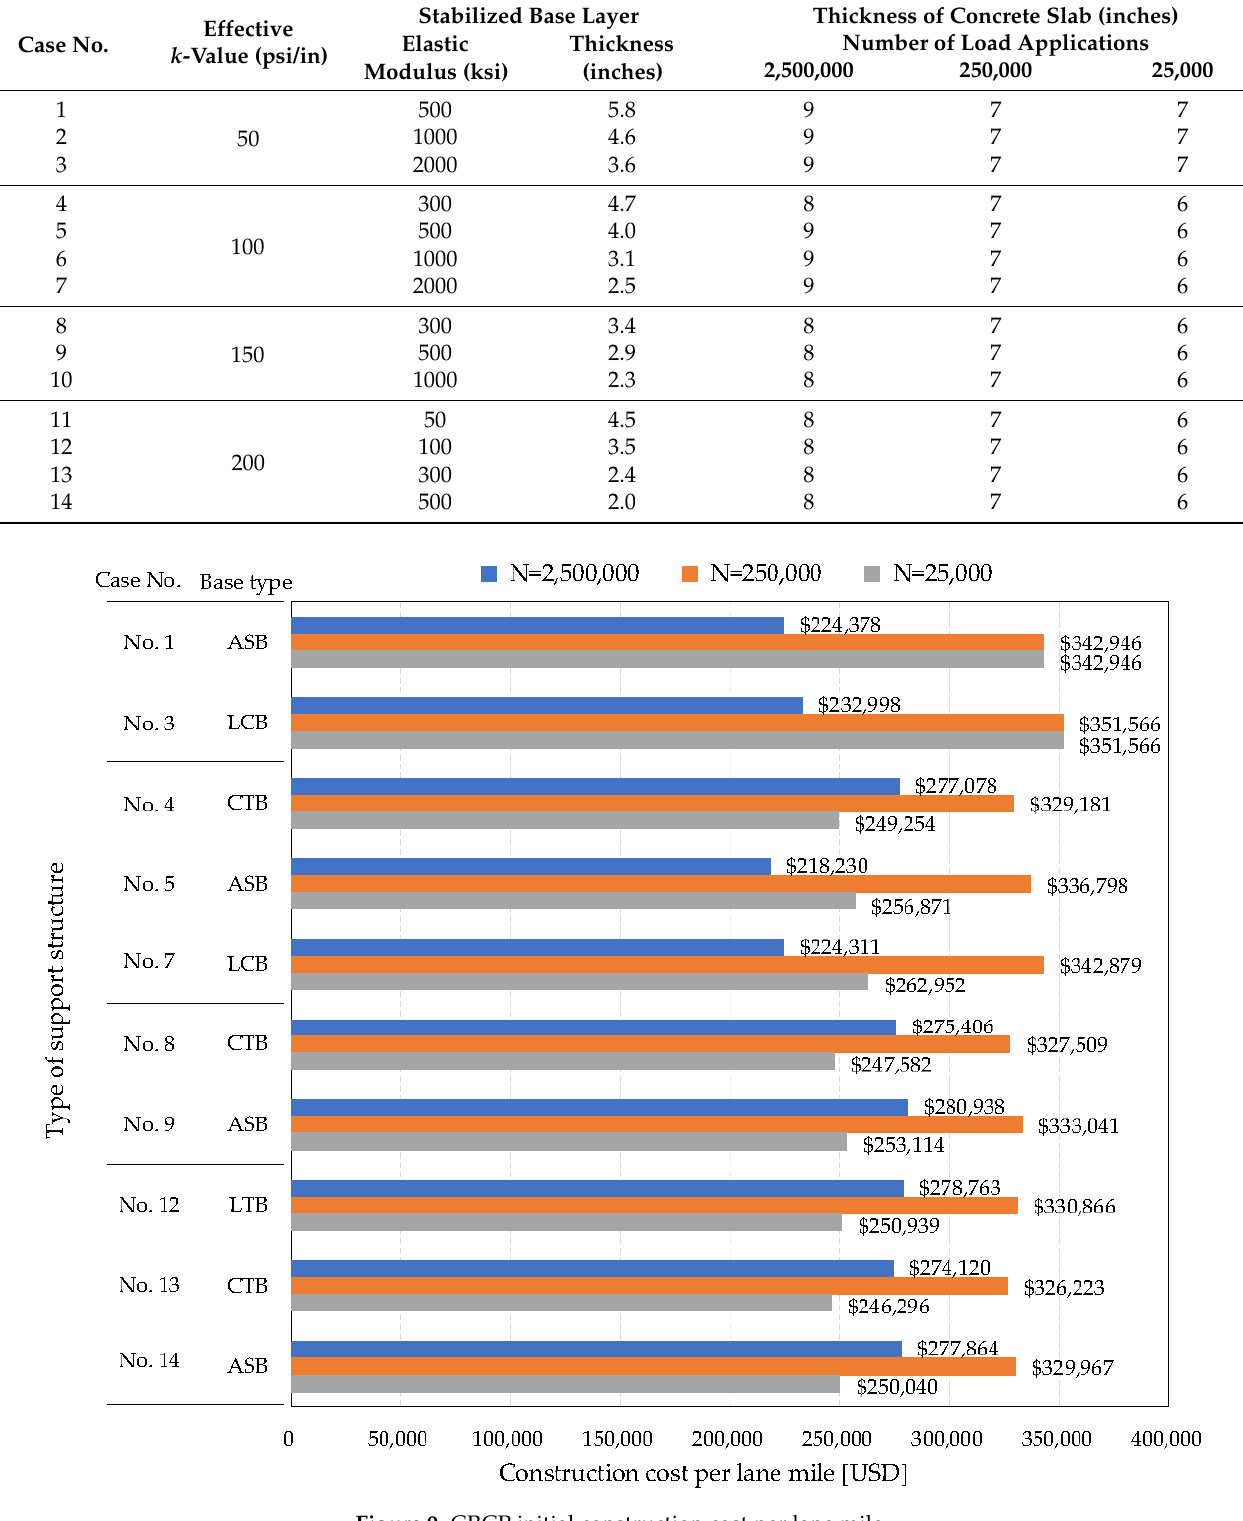
Figure 9. CRCP initial construction cost per lane mile. Table 14. Layer compositions of CRCP structures under the combined loading condition (1 in = 25.4 mm, 1 ksi = 6.89 MPa, 1 psi/in = 271 kN/m 3 ).